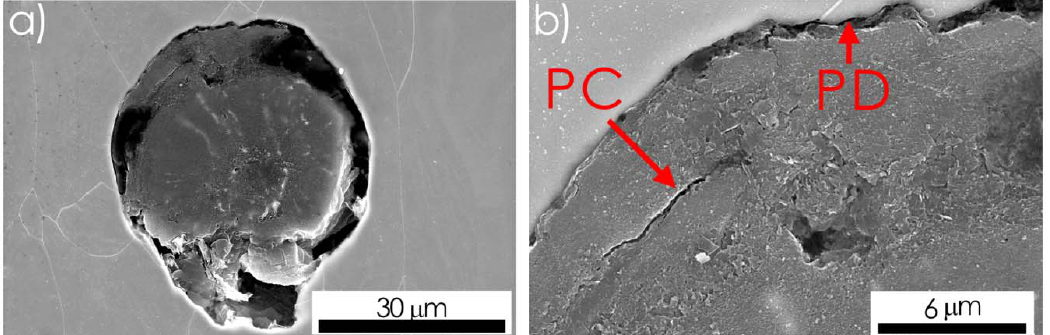
Figure 11. Complete debonding of the graphite spheroid due to the onion ‐ like cracking in spheroid near the fracture surface, specimen SNi9, SEM: ( a ) An outer rim of the graphite spheroid separated from the nodule core; ( b ) area of shifted basal plates locally bonded at the G ‐ M interface (PC: Peripheral crack; PD: Pole debonding).